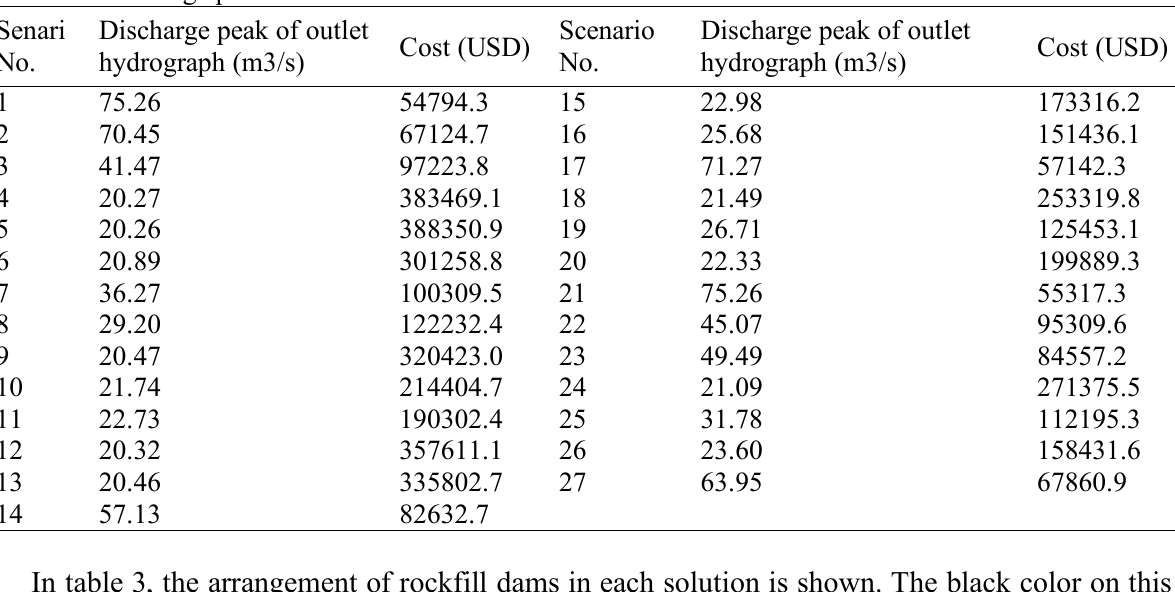
Table 2 . Discharge peak and the cost of rockfill dams on the Pareto's Front